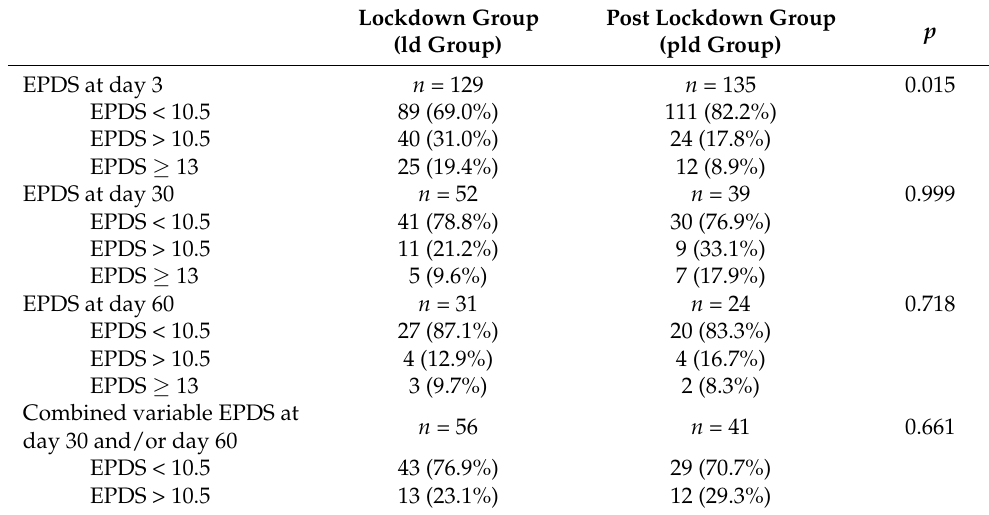
Table 2. EPDS results in the two